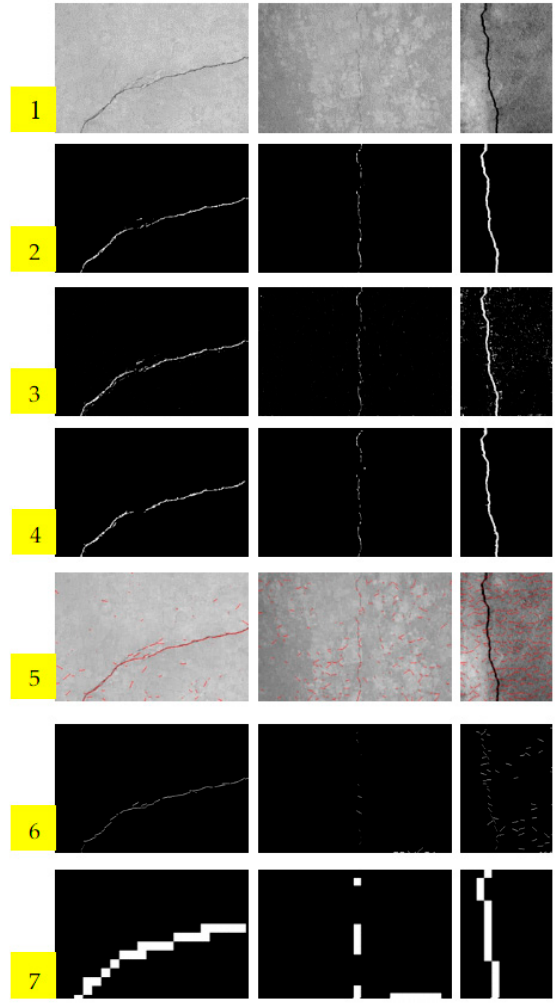
Figure 5. Crack locating results comparison. Row 1: Concrete surface images. Row 2: The ground-truths labeled manually. Row 3: Confidence maps of LPP method. Row 4: Results of LPP method after post-processing. Row 5: Line fitting results of STRUM method. Row 6: Results of STRUM method using AdaBoost classification. Row 7: Results of block-wise CNN method.